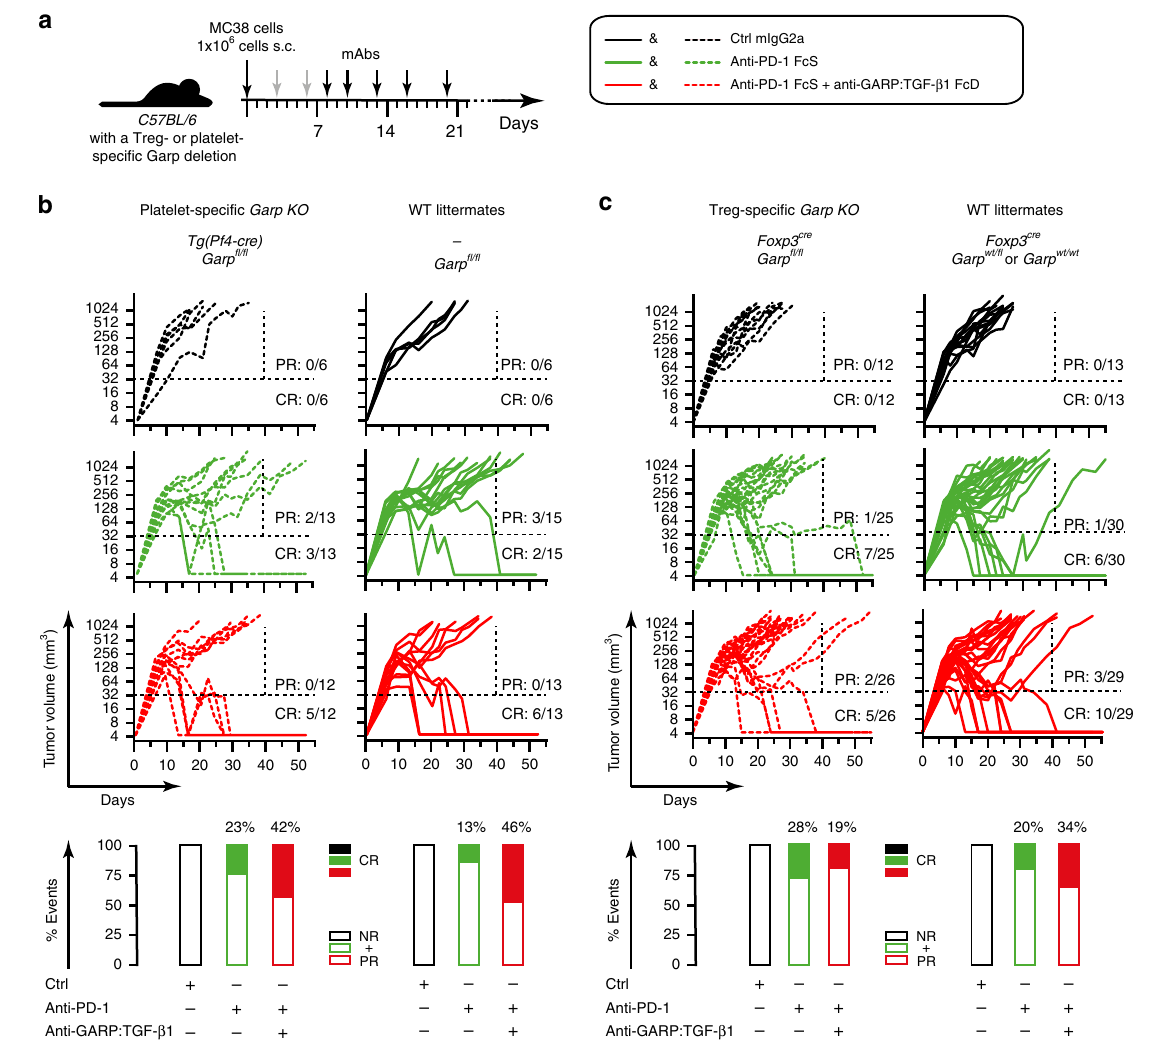
Fig. 7 Targeting GARP on Tregs is suf fi cient to increase the anti-tumor activity of anti-PD-1 blockade. a Schematic representation of the experimental design. Genetically modi fi ed C57BL/6 mice were injected s.c. with live MC38 cells on day 0. Anti-GARP:TGF- β 1 and isotype control mAbs (250 µ g/mouse) were injected i.p. on day 3, 6, 8, 10, 13, 16, and 20 (gray and black arrows). Anti-PD-1 mAb (25 µ g/mouse) was injected on day 8, 10, 13, 16, and 20 (black arrows). Mice were euthanized when the tumor surface was ≥ 200 mm 2 . b Evolution of individual tumor volumes in groups of mice carrying a platelet- speci fi c deletion of GARP (left) and their littermate controls (right). c Same as b , for mice carrying a Treg-speci fi c deletion of GARP (left) and their littermate controls (right). Results pooled from two independent experiments. b , c Each line represents one mouse. Ratios indicate the proportions of CR (live mice with no detectable tumor at the end of the experiment) and PR (mice alive on day 40 that carry a tumor >32 mm 3 at the time of euthanasia). Dotted horizontal and vertical lines indicate the two arbitrary limits (tumor volume of 32 mm 3 and day 40) used to identify PR and CR. Rectangles on the bottom represent proportions (%) of CR ( fi lled rectangles), and partial + non-responders (PR + NR, empty